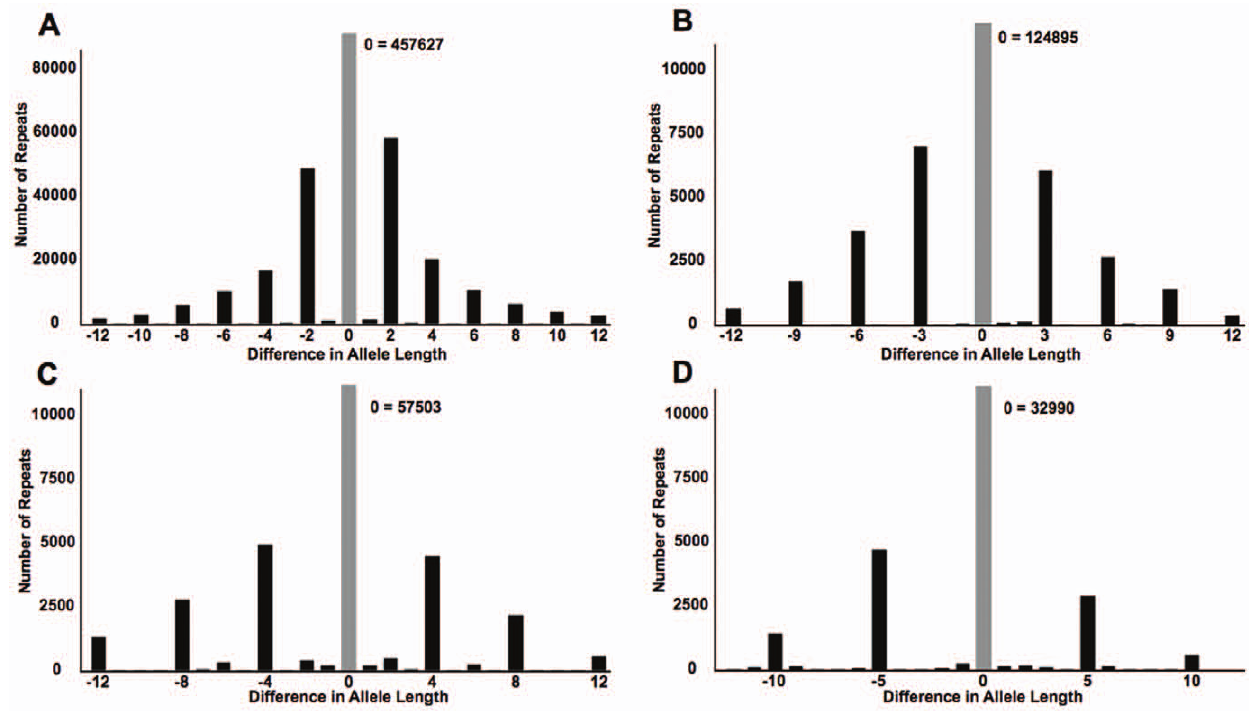
Figure 7. Changes in repeat length typically occur in the form of insertions and deletions of whole repeated units. The plotted dataset consisted of repeats that were at least 90% pure, with a minimum reference repeat length of 13, 20, 23, and 27 bases for (A) 2mers, (B) 3mers, (C) 4mers, and (D) 5mers, respectively. Genotypes were determined if there were at least two scorable reads and a read was scored if it spanned the repeat region with 3 or more matching flank bases on either side of the repeat.